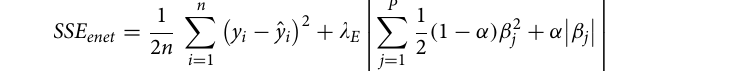
where SSE enet represente the elastic net loss function to be minimised, i denoted each simulated observation and n the number of observations, y i and ŷ i were respectively the simulated and model predicted outcome for the ith observation, j denoted a predictor variable with p the number of predictor variables selected in the model through minimisation of the loss function (some variable coefficients are set to zero meaning the y are not selected in a final model), and |β| represented absolute values of the regression coefficients. The hyperparameters that represent the penalty (λ E ) and the relative proportion of penalisation on either the sum of the square of the coefficients or the unsquared coefficients (α) were optimised by 10 × tenfold cross validation to minimise mean absolute error (MAE). Elastic net models were built using the glmnet package 29 using the caret package platform 30 in R 24 . Smoothly clipped absolute deviation and minimax convex penalty. Smoothly clipped absolute deviation (SCAD) 26 and minimax convex penalty (MCP) 27 are also forms of regularised regression. A feature of these methods is that the size of the penalty function varies with the size of variable coefficient, β. Both methods can be described by the general framework;